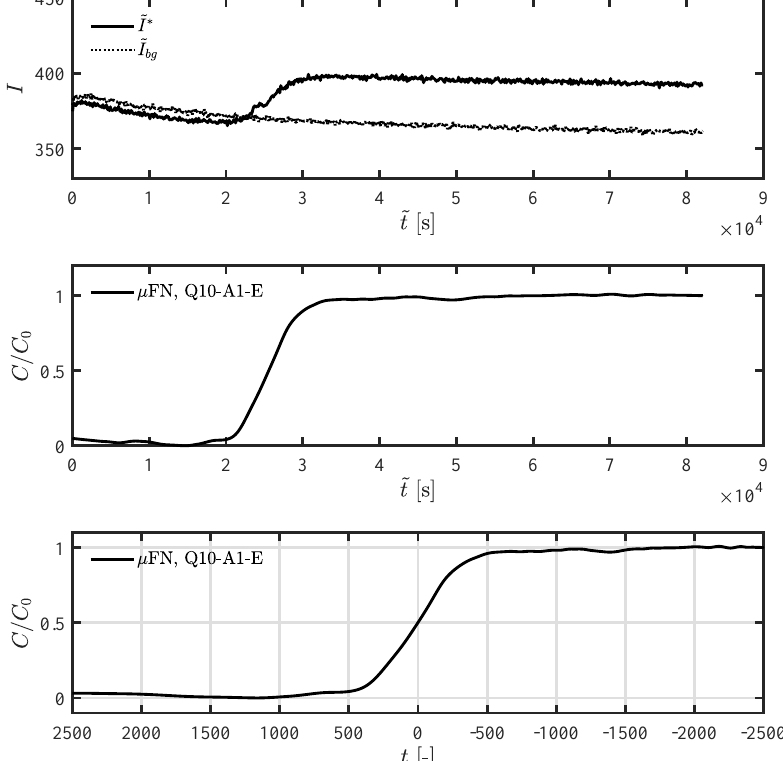
Figure 5. ( Top ) Measured light intensity (˜ I ∗ , solid line) at location A1-E of the µ FN for Q = 10 µ L/h and measured background measurement (˜ I bg , dashed line) next to A1-E; ( Middle ) normalized concentration as a function of physical time (˜ t ); and ( Bottom ) normalized concentration as a function of normalized time ( t